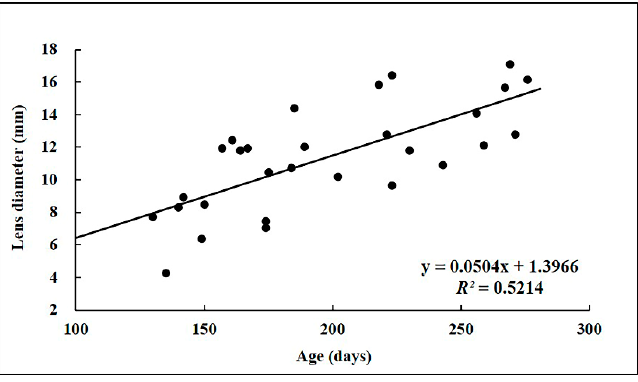
Figure 4. Correlation between age and lens diameter for O. bartramii .